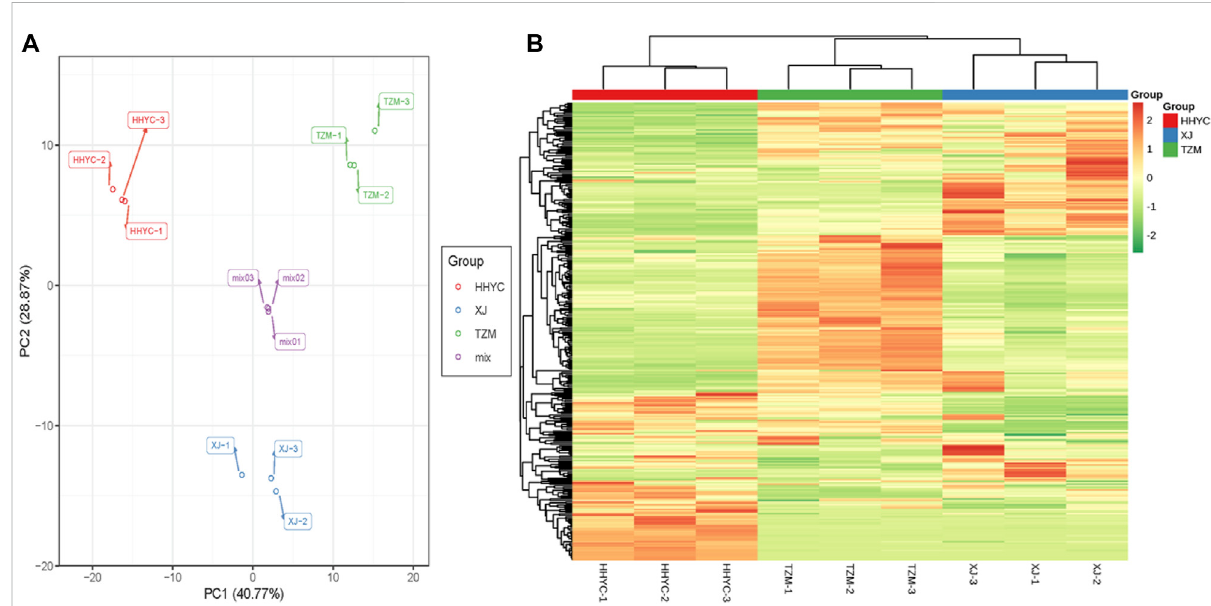
FIGURE 5 Pro fi les of metabolites accumulated among the 3 from petals of contrasting fl owers of C. reticulata (HHYC; red colored), C. reticulata ‘ Xuejiao ’ (XJ; pink colored) and C. reticulata ‘ Tongzimian ’ (TZM; white colored). (A) . Principal component analysis based on metabolites normalized ion intensities. Mix samples represent equal proportion of samples from HHYC, XJ and TZM. Metabolome pro fi ling was done in triplicates for each genotype (HHYC-1 to -3, XJ-1 to -3, TZM-1 to -3 and mix-1 to -3). (B) . Hierarchical clustering heatmap based on metabolites normalized ion intensities. The red, blue and green colors on column cluster (shown righthand side) represent HHYC, XJ and TZM, respectively. The ion intensity of each metabolite are shown green color represents lowly-accumulated, and red color represents highly-accumulated